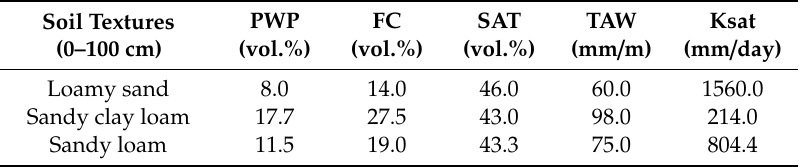
Table 4. Calibrated soil properties and descriptions in